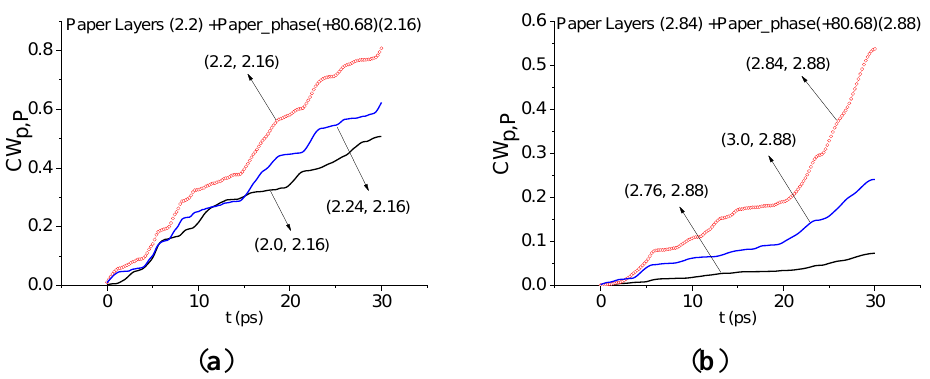
Figure 10. The transmitted THz Paper_phase(+80.68) signal ( a ); Fourier spectrum of the main pulse in the frequency range ν = [0, 2.0] THz ( b ); [1.6, 3.0] THz ( c ).